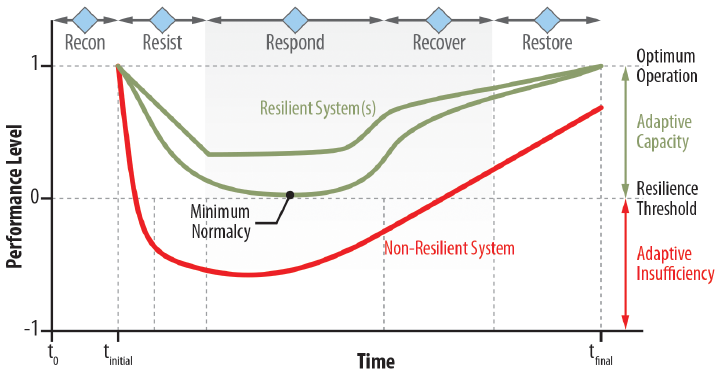
Figure 4. Disturbance and impact resilience curve of power systems